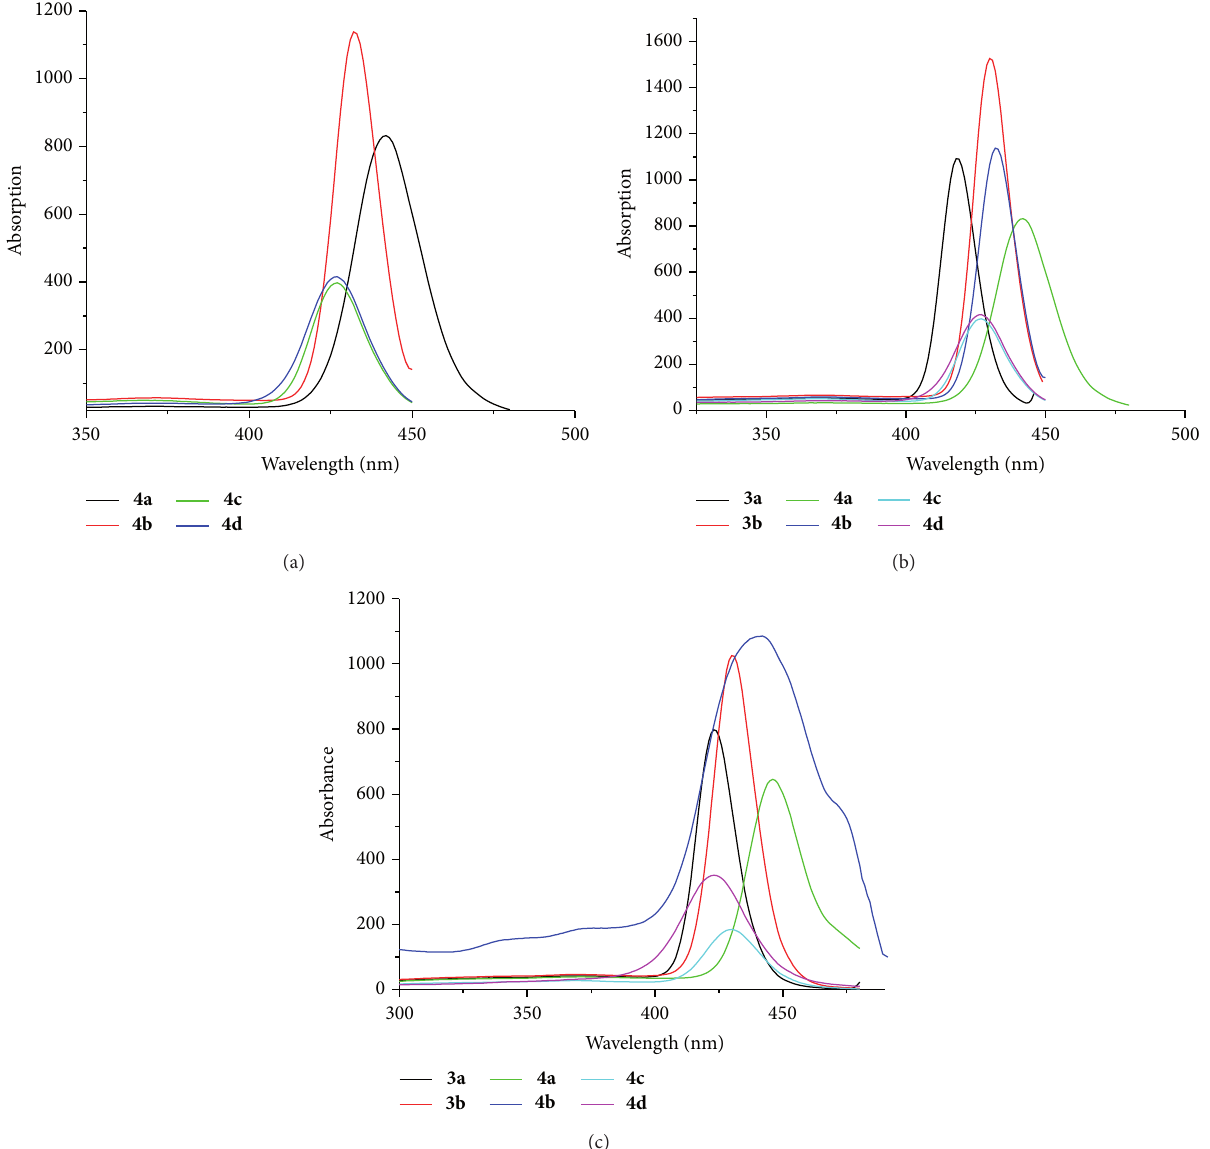
F 1: Absorption spectra of compounds 3(a-b ) and 4(a – d) in different solvents; 1(a) chloroform, 1(b) THF, and 1(c) DMSO.